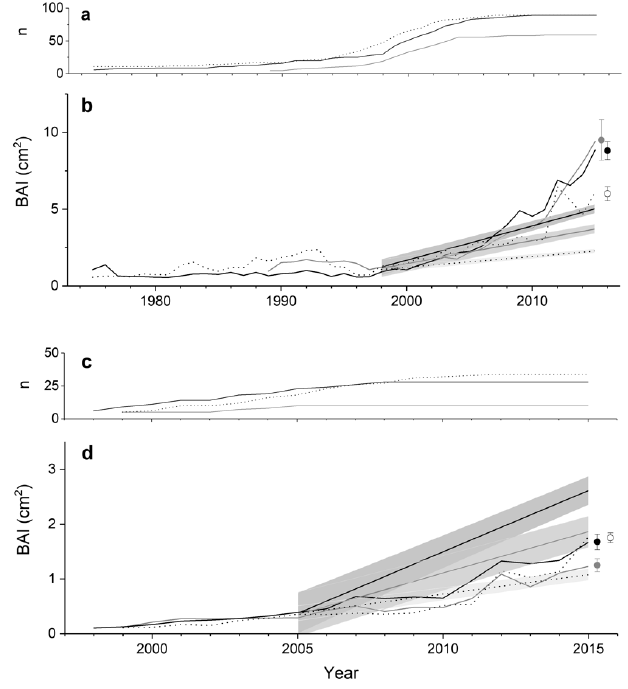
Figure 6. Sample depth and basal area increment (BAI) of tree species at treeline ( a , b ) and krummholz limit ( c , d ). Pinus cembra = continuous black line; Picea abies = continuous grey line; Larix decidua = dotted black line. Variance among samples is indicated by mean standard error. Species-specific age trends in BAI were plotted based on regression equations given in Figure 5. 95% confidence intervals are indicated. Onset of age trend in BAI was assumed to occur at the time when continuous growth increase was detected (for details see Materials and